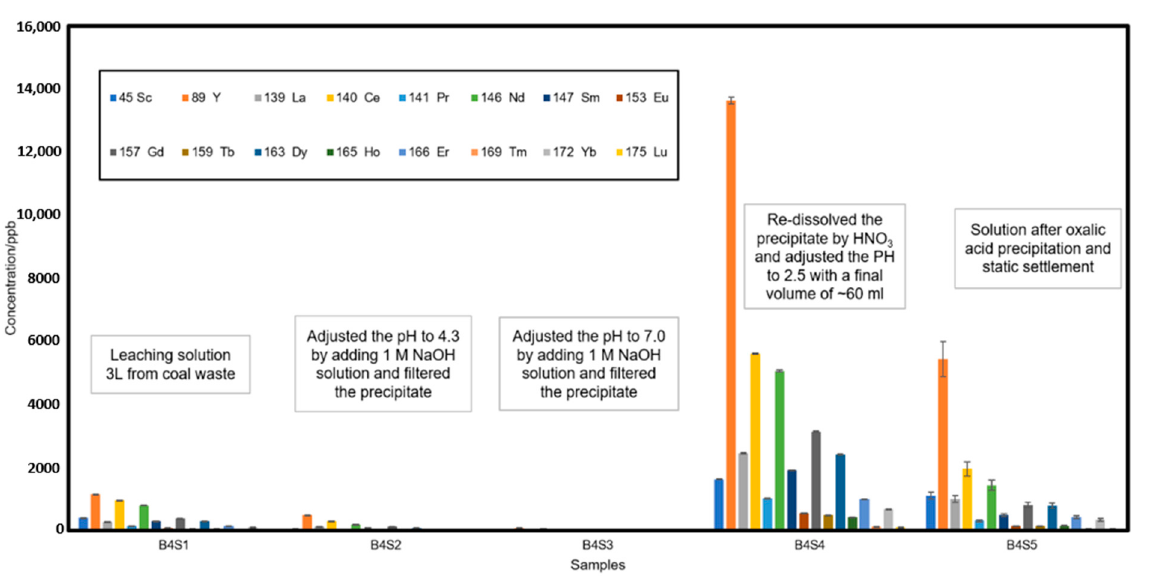
Figure 6. Rare earth element concentrations in the process solutions of B4 test.